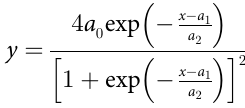
PLOS ONE | https://doi.org/10.1371/journal.pone.0250699 April 23,